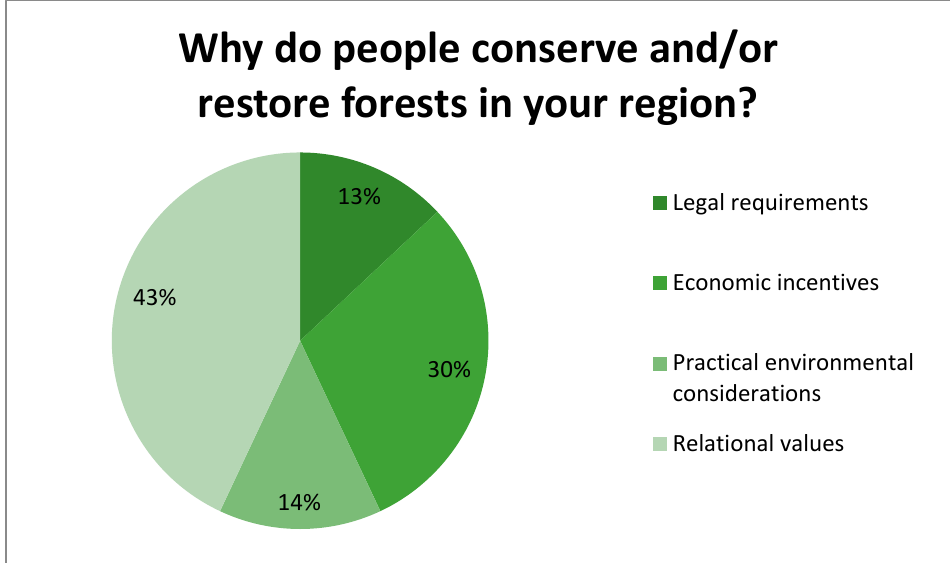
Figure 2. Elements influencing forest conservation and/or restoration in the Brazilian Amazon.